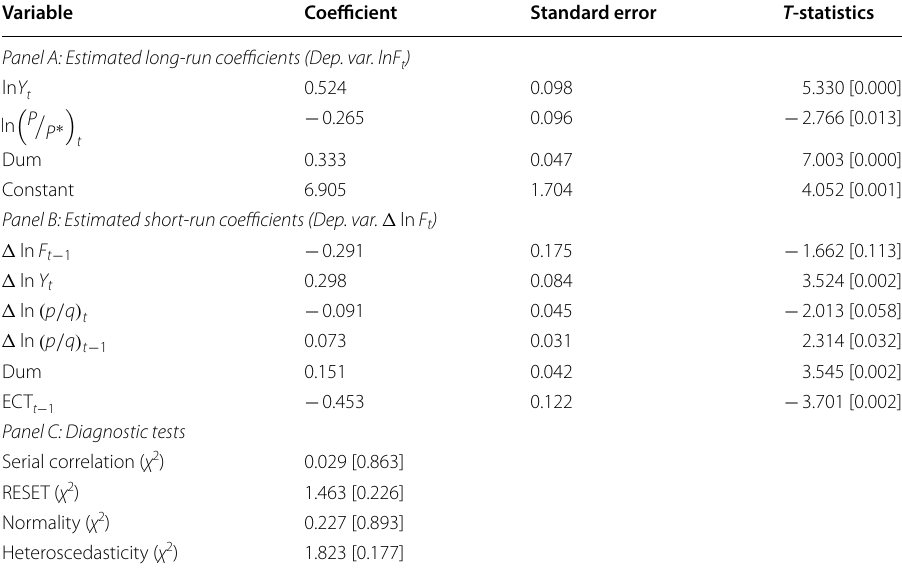
The optimal lags of the ARDL model are selected based on SBC. Bracket represents probability values